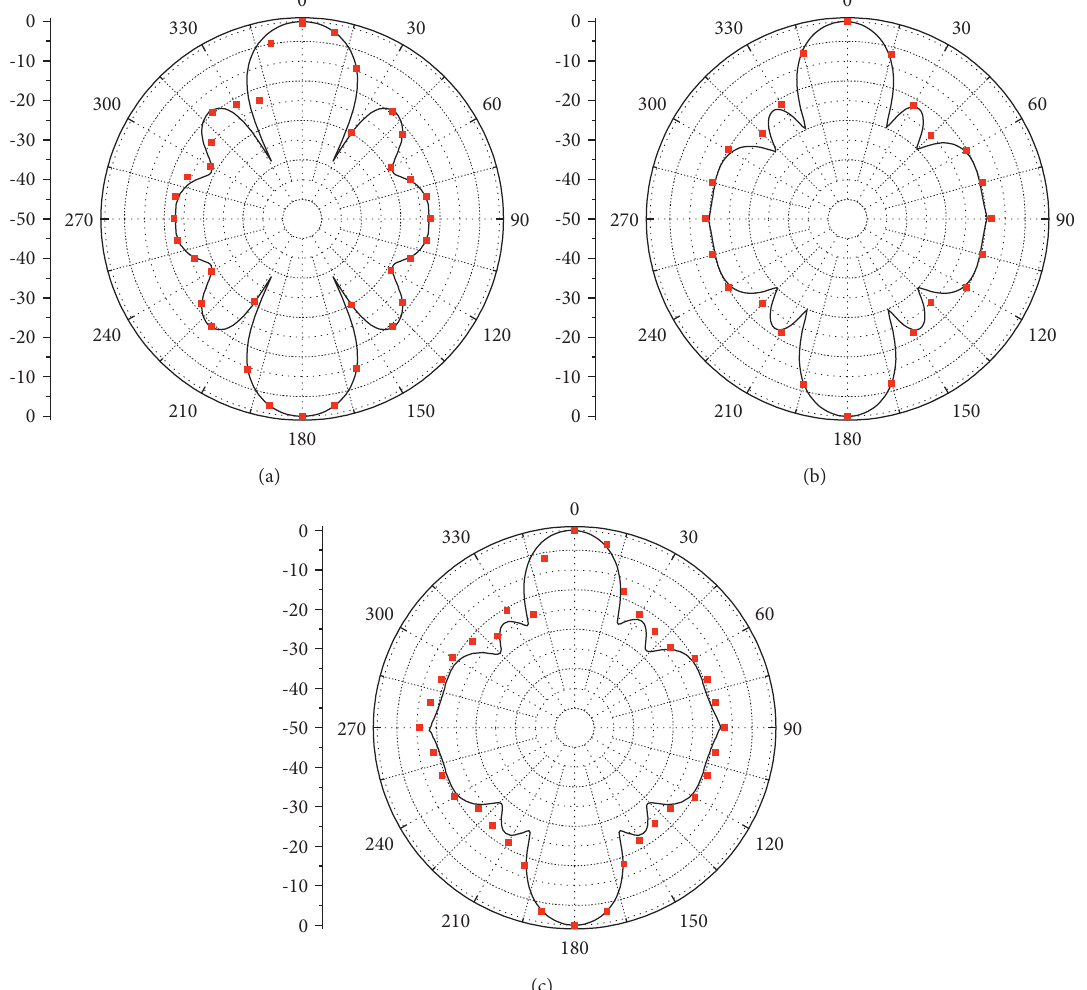
Figure 11: Simulated and measured radiation characteristics of the proposed array for the xz -plane at (a) 23GHz, (b) 28GHz, and (c) 29GHz ( − simulated and ▀ measured).